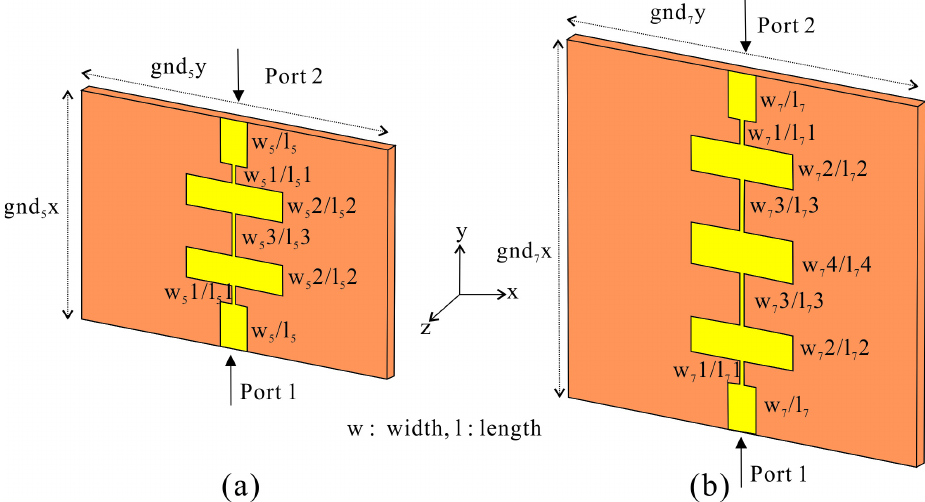
Figure 3. The low-pass filter configuration is designed to suppress the harmonics of the proposed